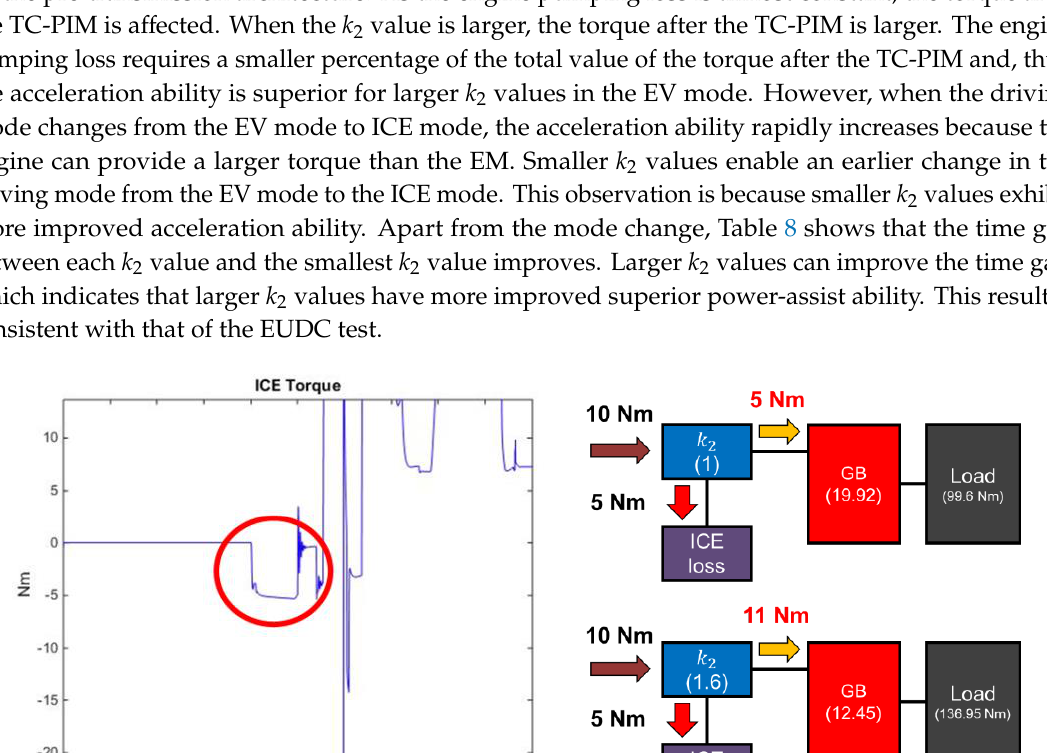
Figure 18. ( a ) Acceleration time compared with different 𝑘 2 values. ( b ) Acceleration in mode change phase (EV to ICE).